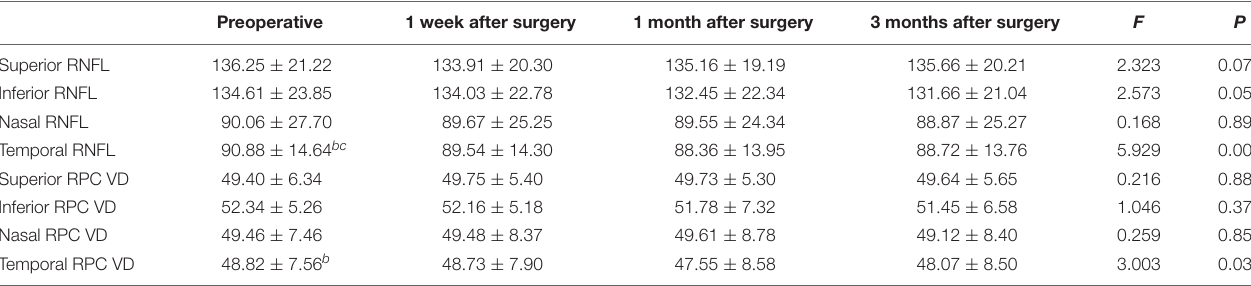
TABLE 4 | Para-disk nerve fiber layer thickness and the blood flow density of radial peripapillary capillaries (RPC). Preoperative 1 week after surgery 1 month after